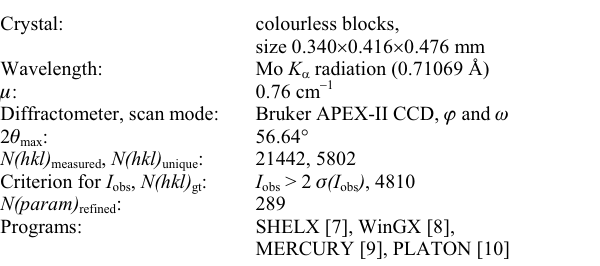
Table 1. Data collection and